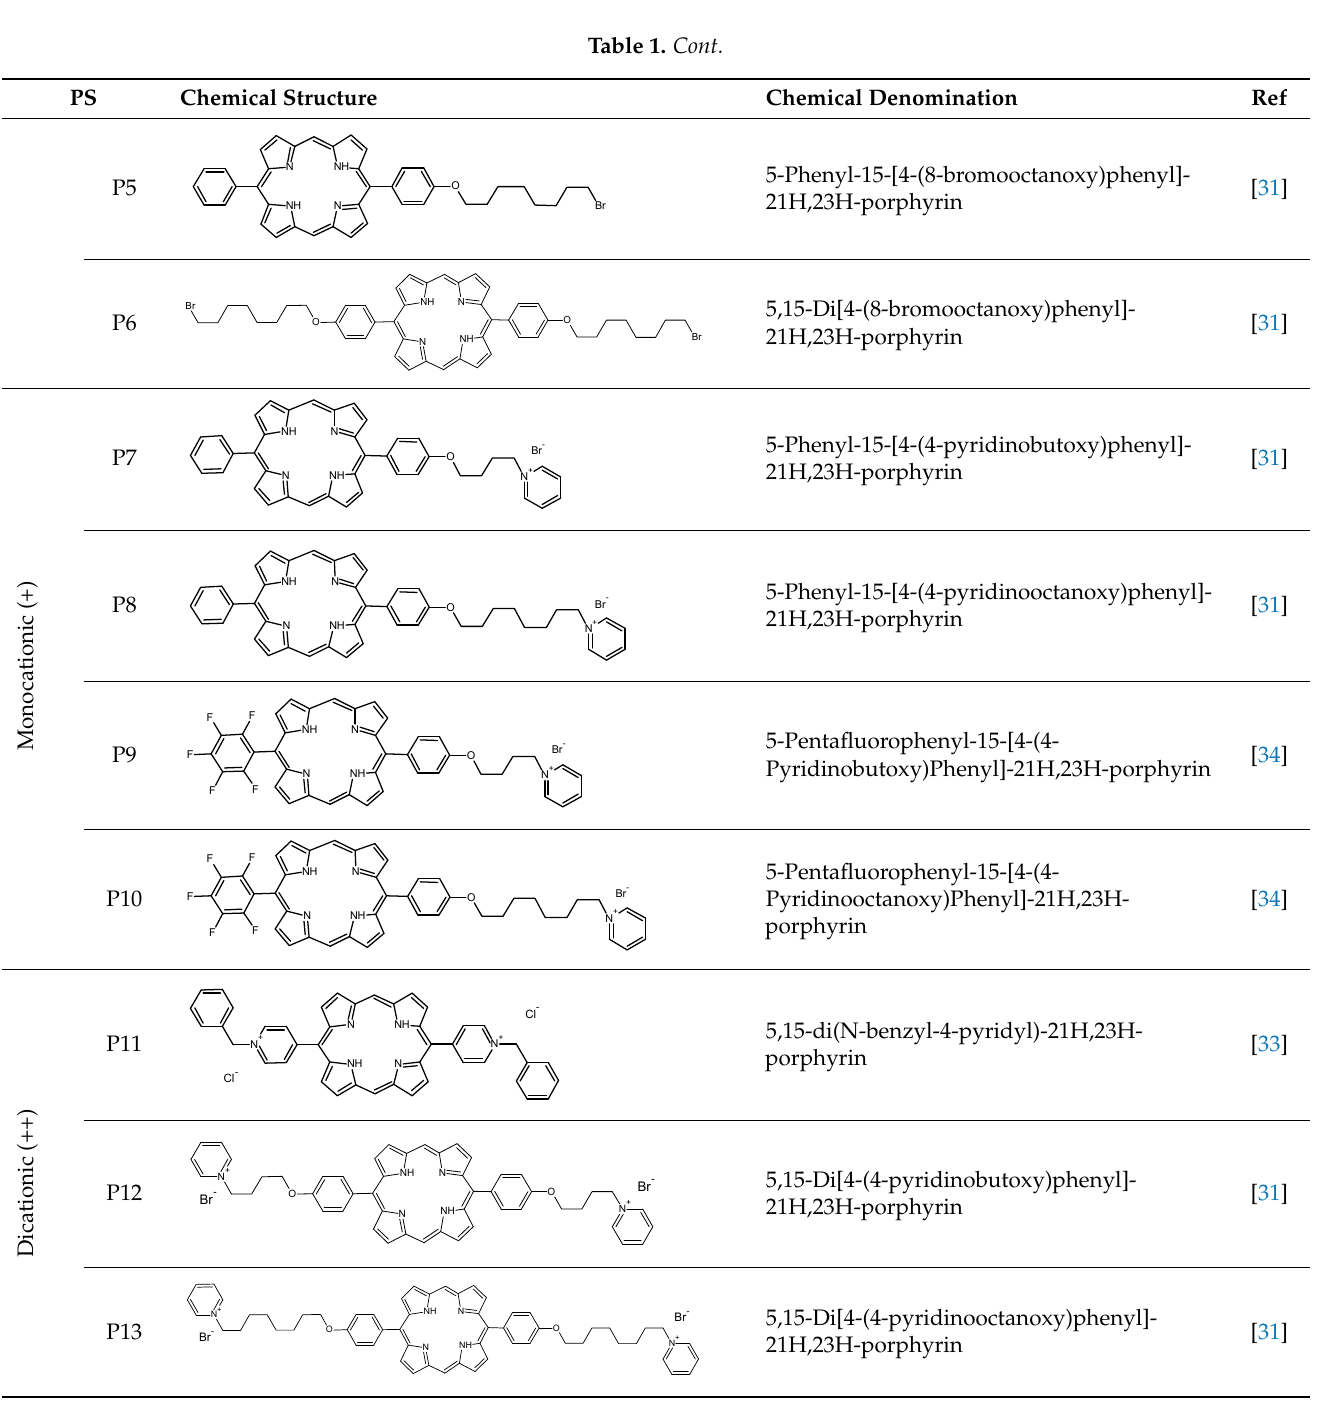
Figure 1 . Analysis of intrinsic toxicity of diaryl-porphyrins (P1-P13). PSs were administered at a con- centration of 10 µM to samples of P. aeruginosa PAO1 at decreasing concentrations (from 10 9 up 10 4 CFU/mL). After dark incubation for 10 min, 1 and 6 h, volumes of ~5 µL of each sample were replica plated on LB agar. After overnight incubation at 37 °C, the growth spots were checked. In the second column, Log10 reduction values represent the mean of three independent experiments for each dark incubation. Representative images reported in the last column refer to growth spots at the corre- sponding bacterial denisities (from 10 7 to 10 2 CFU/spot) upon 6 h of dark incubation with the tested PS. Each experiment has been repeated at least three times with independent cultures. 2.2. Diaryl-Porphyrins Binding and Photoinactivation Rates As an optimal interaction between PS and microorganism is required for the follow- ing oxidative stress elicited by irradiation [36], the binding rate of porphyrins to microbial cells was evaluated. The yield of PS binding was strictly related to diaryl-porphyrin charge. After 1 h of dark incubation, neutral PSs (P1-P6) showed a very low affinity, less than ~8% of PS binding except P2 with a binding yield of ~15% (Figure 2). On the